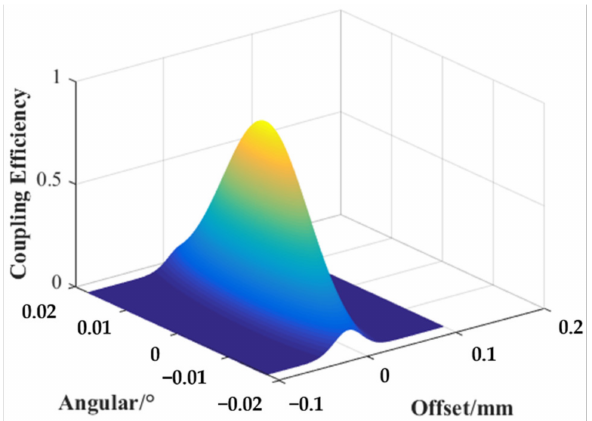
Figure 8. The coupling efficiency with different angular and transverse offsets.